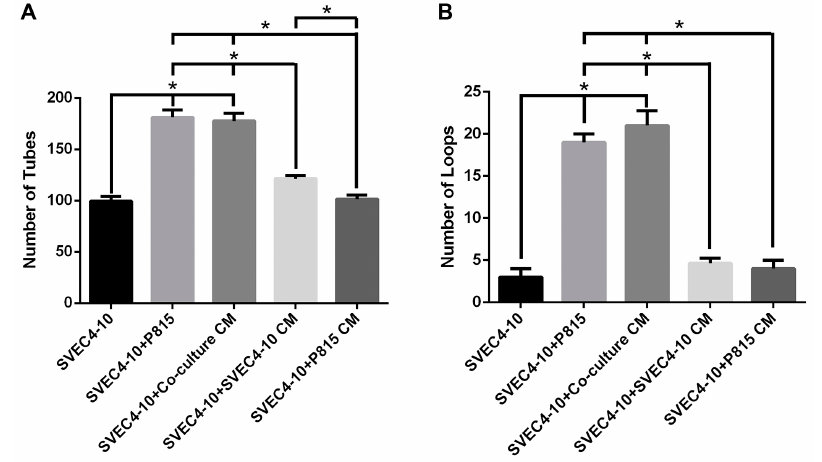
Figure 7. Conditioned medium from the co-culture increases in vitro angiogenesis. The conditioned medium from the co-culture of SVEC4-10 cells and P815 mast cells demonstrated the same ability as co-culture with mast cells to increase in vitro angiogenesis. ( A , B ) The conditioned media from SVEC4-10 induced a slight increase in tubes ( A ) but not in loops. The graphs show the average number of tubes and loops after 5 h of culture. The structures were quantified using Wimasis WimTube. Data are presented as mean ± SD from five independent experiments. CM (Conditioned media) * p ≤ 0.05.